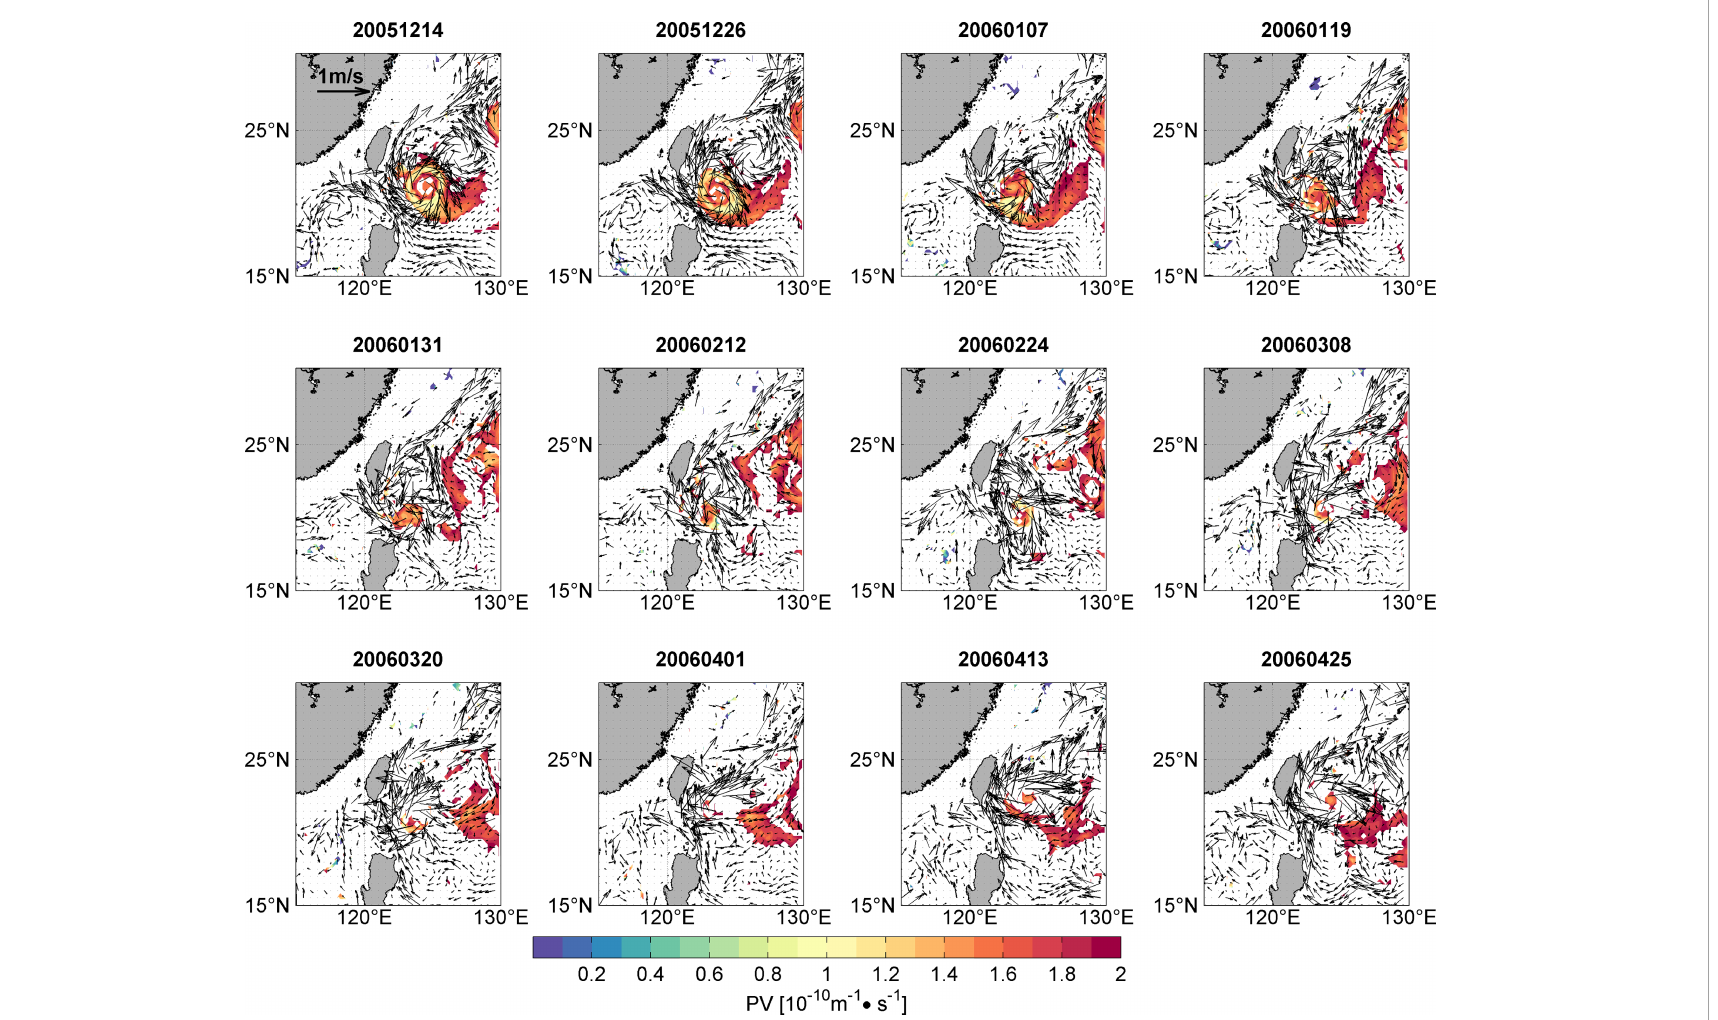
The process of a low PV signal (colors, unit: 10 − 10 m − 1 · s − 1 ) disappearing east of the Luzon Strait in the 25.3 s q isopycnal layer in the 2006 case. Vectors represent currents (unit: m · s − 1 ) in the 25.3 s q isopycnal